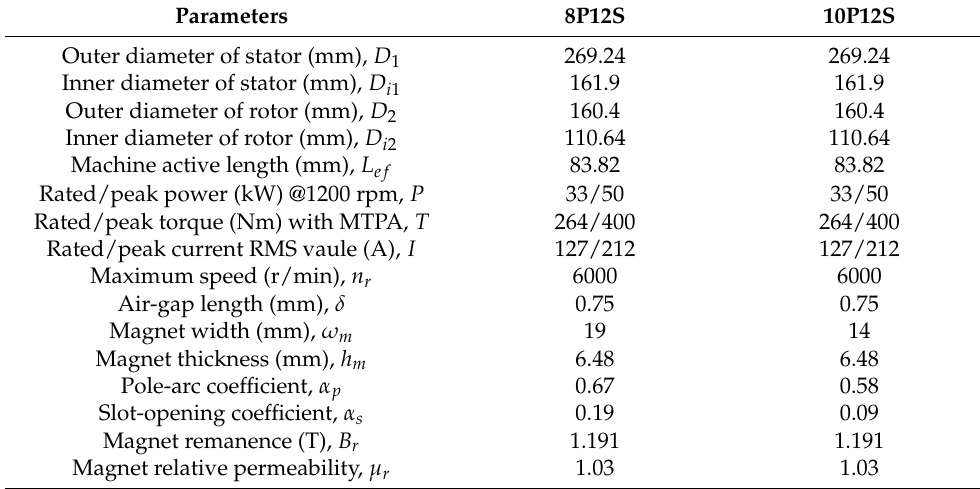
Table 1. Main design parameters of the selected